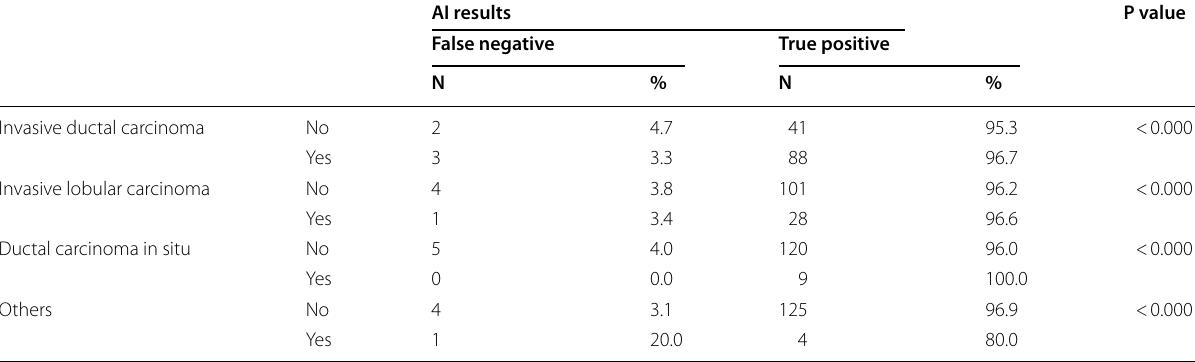
Table 2 Sensitivity of AI in detecting different pathological types of breast malignancy